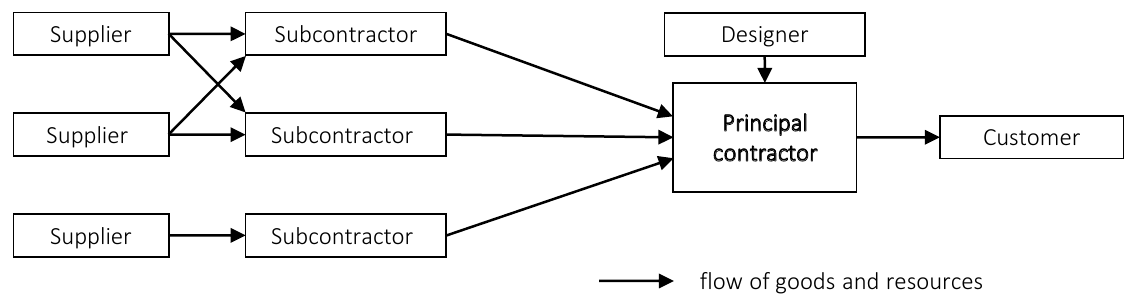
Figure 1. Concept of simplified project supply